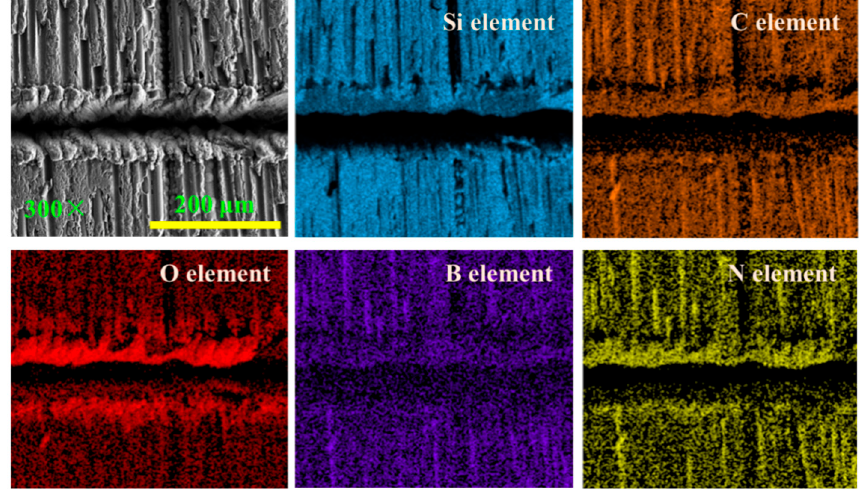
Figure 12. Distribution of different elements of fiber longitudinal arrangement and laser transverse scanning region.